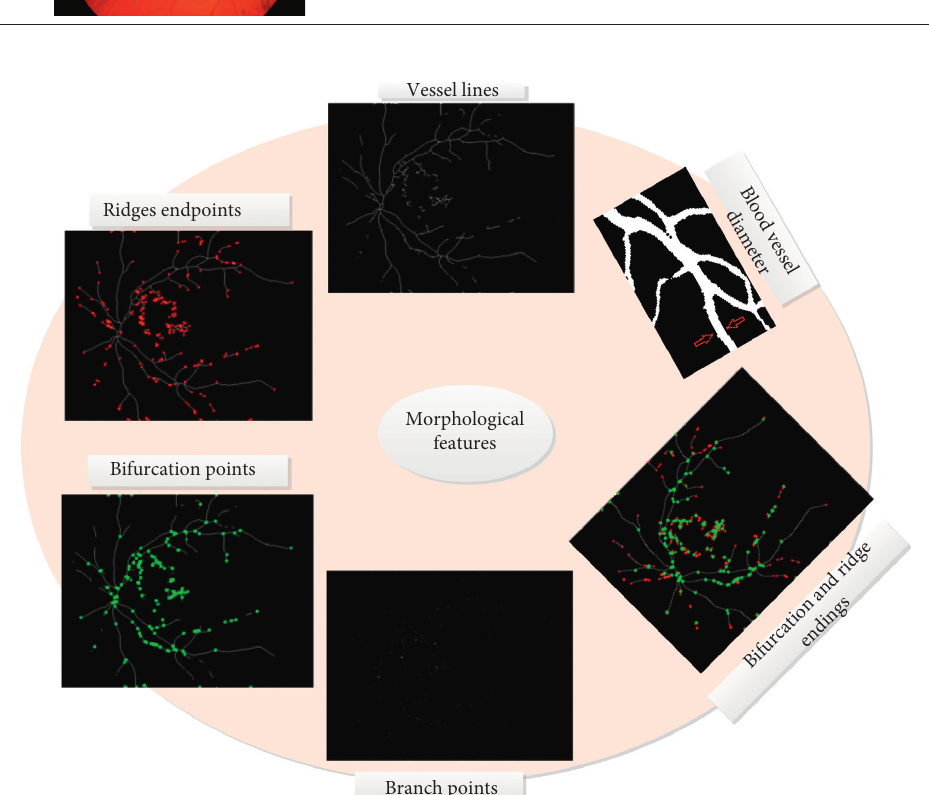
Figure 6: Samples of morphological features extracted from segmented retinal blood